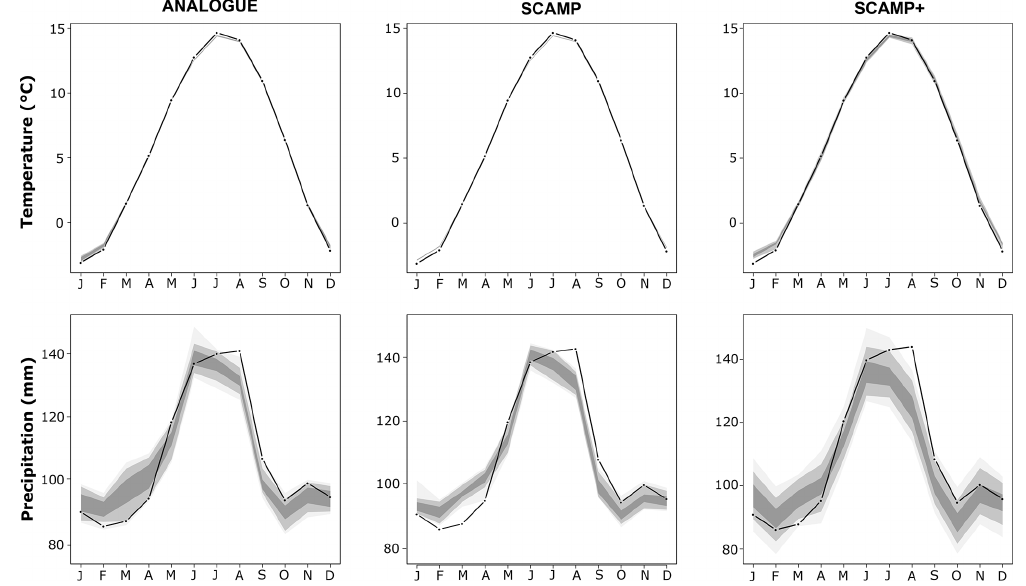
Figure 6. Observed and simulated seasonal cycles of temperature and precipitation for ANALOGUE, SCAMP and SCAMP + . The grey shadings present the inter-quantile intervals at 50%, 90% and 99% levels. Simulated seasonal cycles are obtained using 30 scenarios of 111 years from ANALOGUE and SCAMP and 300 scenarios of 100 years from SCAMP +